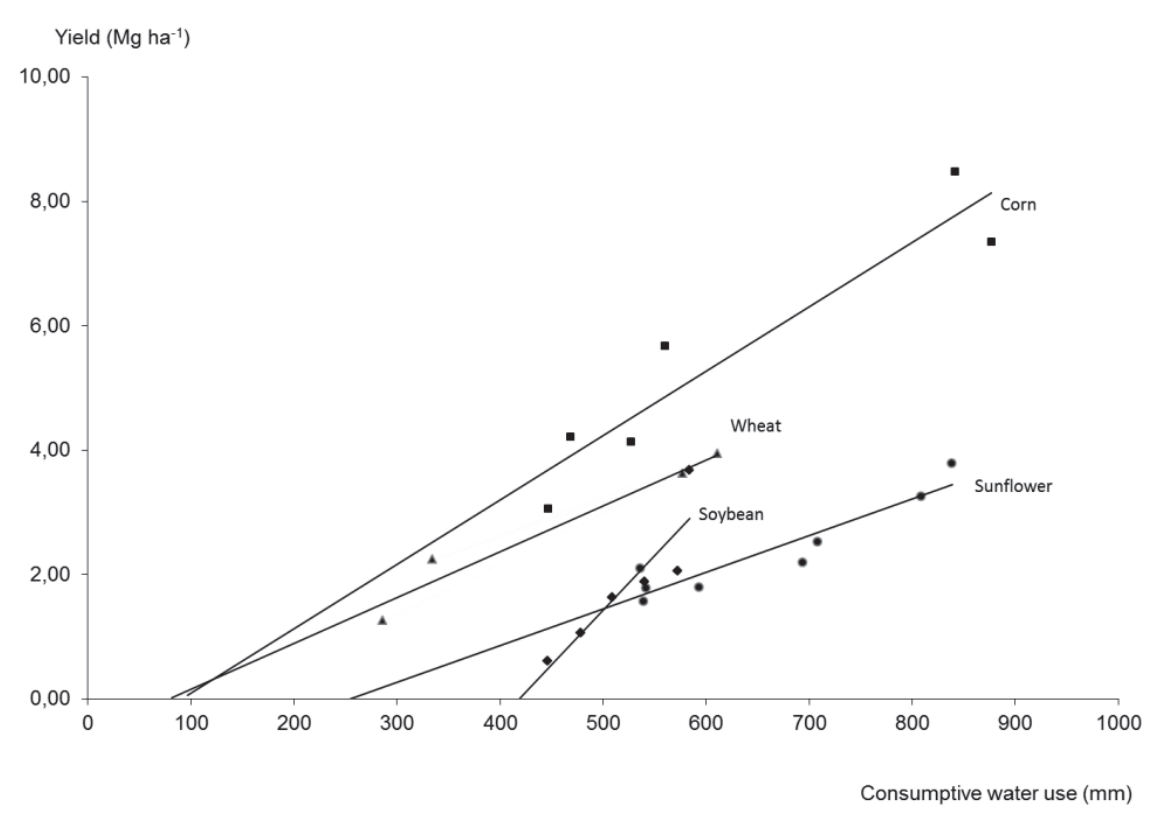
Figure 3. Crop yields as a function of available water contents at seeding plus rainfall during the season for sunflower, corn, wheat, and soybean. Regression lines were extrapolated to the origin to compare estimated water losses. The regression coefficients were R 2 =